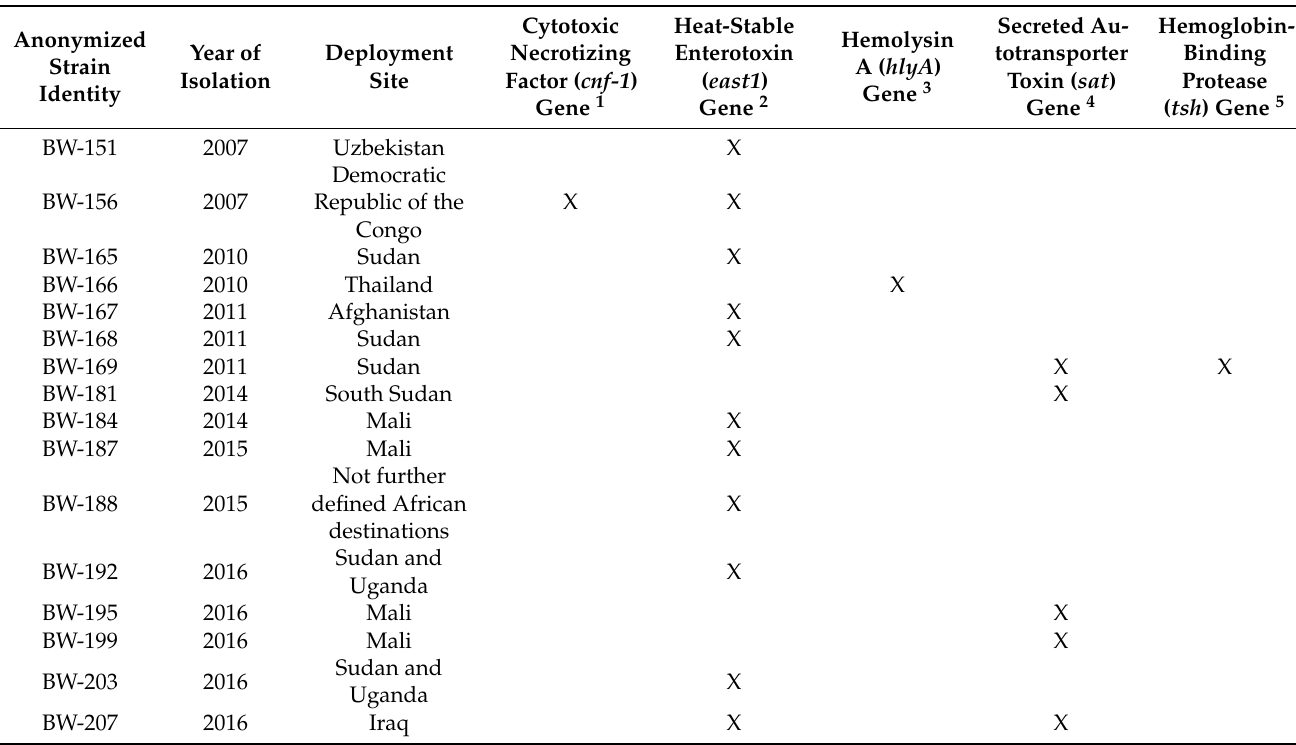
Table 4. Distribution of chosen virulence factor genes (sequence identity ≥ 99%) within the assessed Escherichia coli strains. Only isolates with identified virulence factors are